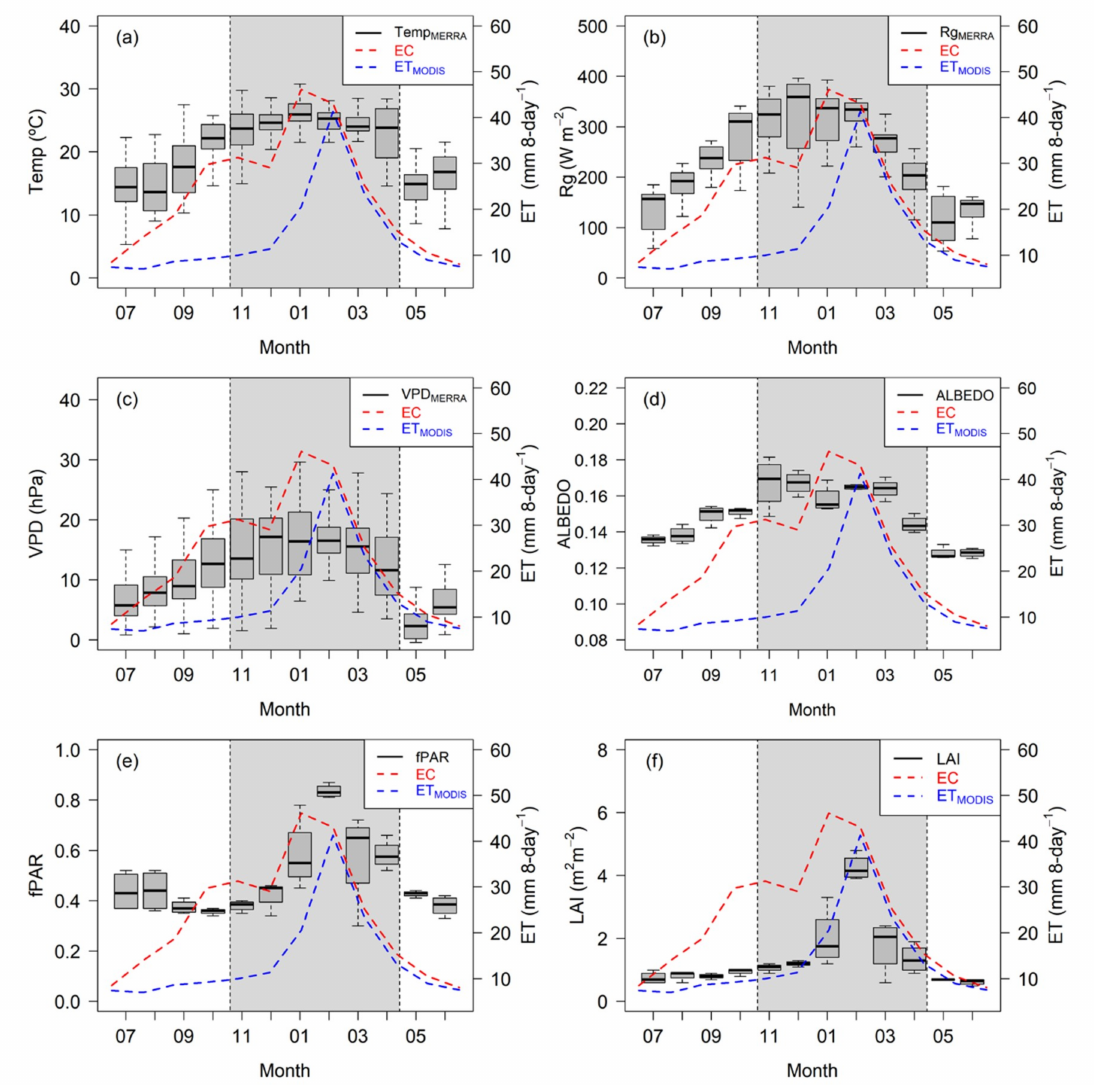
Figure 5. Seasonal pattern of EC measurements, MOD16 ET estimates and environmental variables (derived from MODIS remote sensing and MERRA reanalysis) from July 2003 to June 2004 at the PRS site. The grey boxes represent the inter-quartile range (IQR), the black tick lines represent the median and the whiskers indicate variability outside the upper and lower